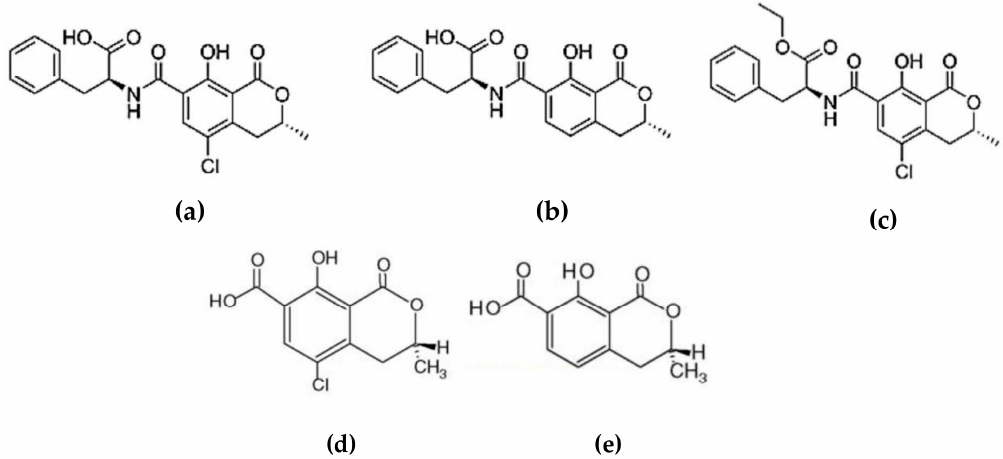
Figure 1. Structures of ochratoxin A ( ΟΤ A) ( a ), ochratoxin B ( ΟΤΒ ) ( b ), ochratoxin C (OTC) ( c ), ochratoxin α (OT α ) ( d ) and ochratoxin β (OT β ) ( e ).